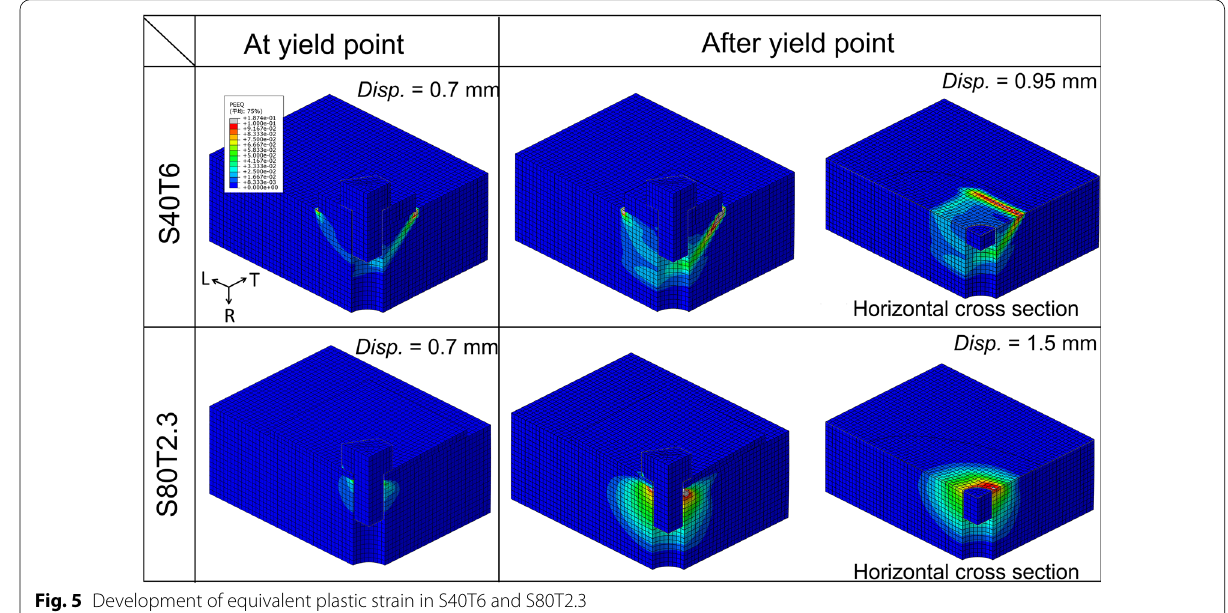
Fig. 5 Development of equivalent plastic strain in S40T6 and S80T2.3